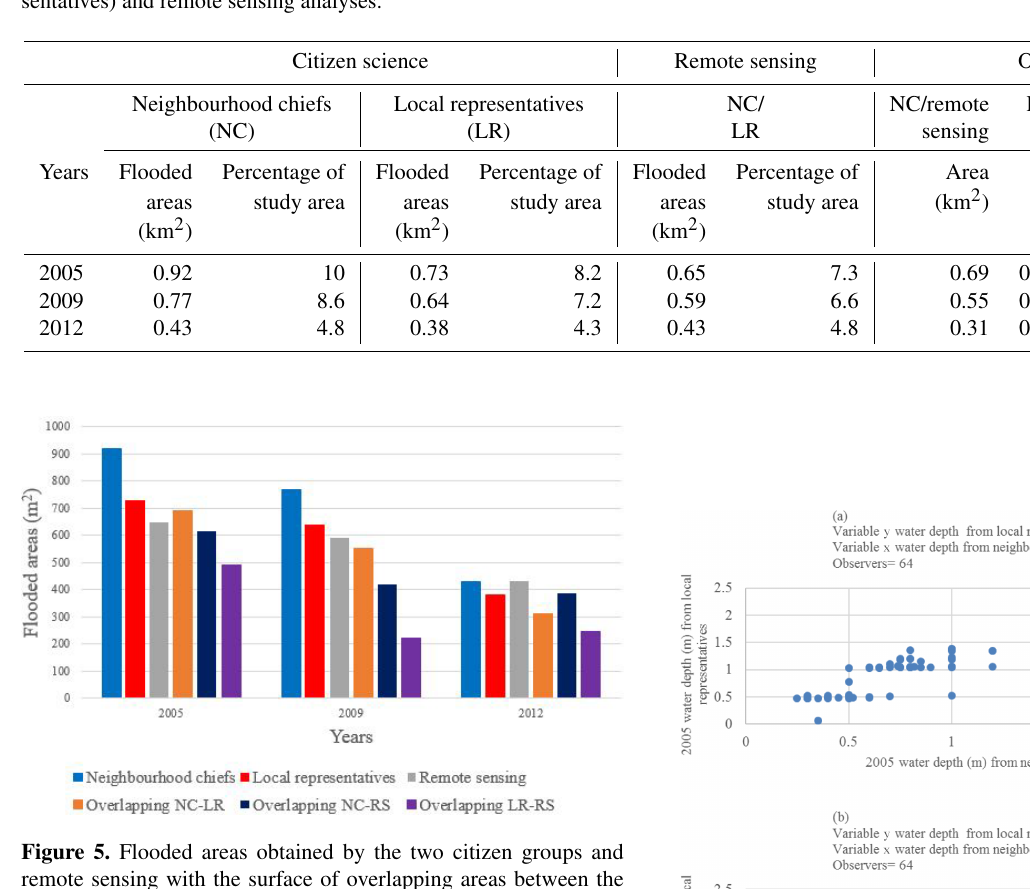
Table 3. Comparison of flooding areas from citizen science techniques deployed in Yeumbeul North (neighbourhood chiefs and local repre- sentatives) and remote sensing analyses.